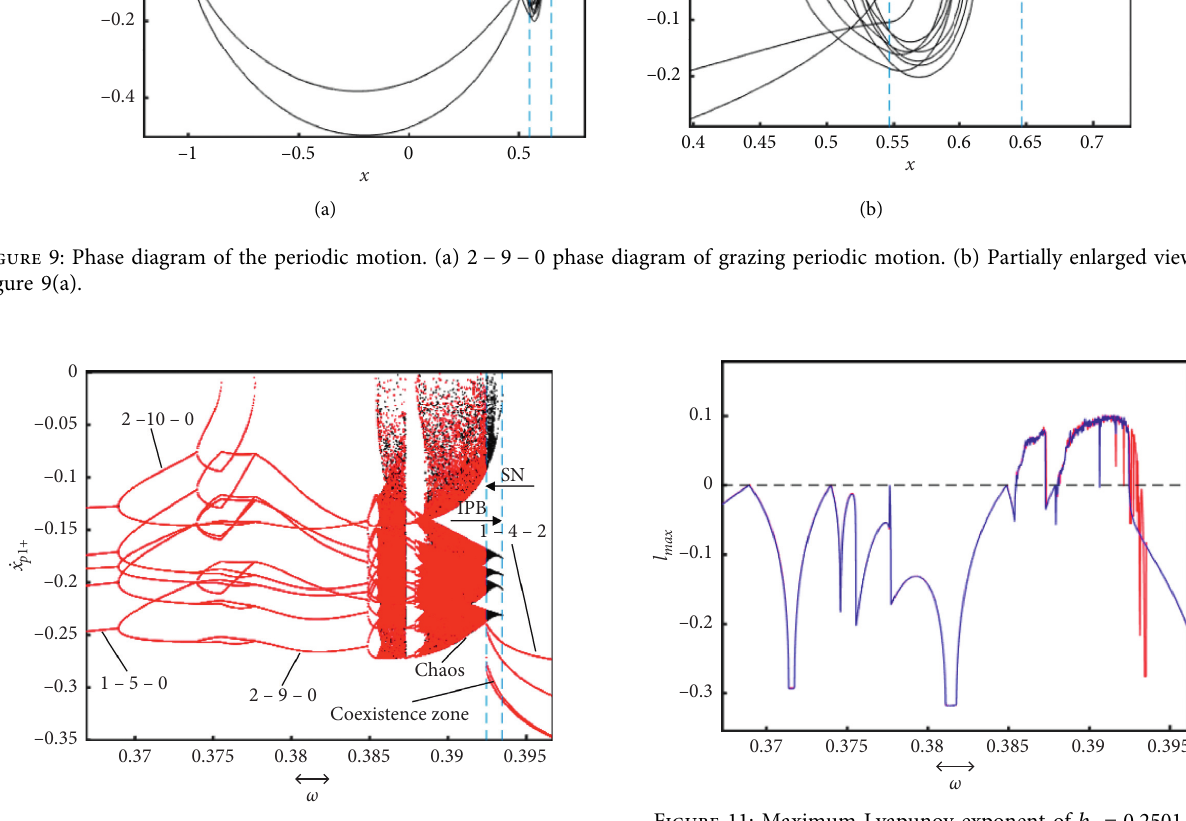
Figure 10: Bidirectional single parameter.